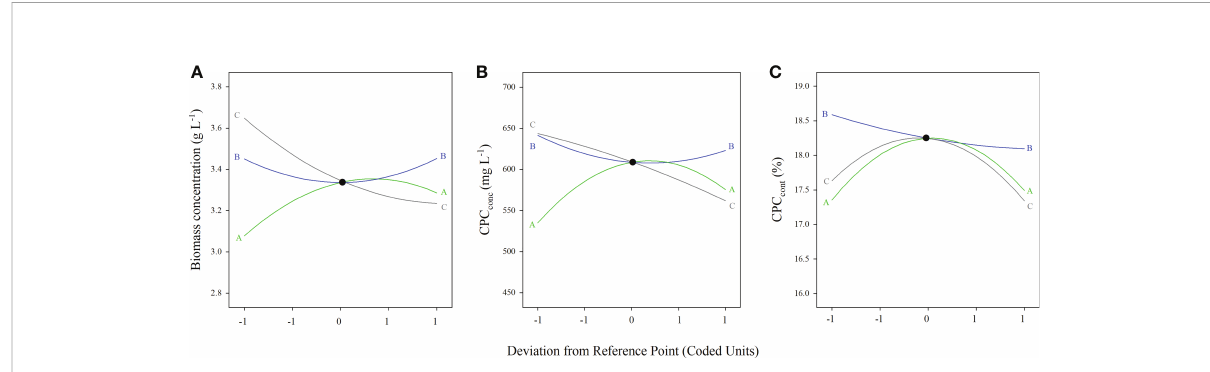
FIGURE 1 Perturbation plots of the dependent variables. (A) biomass concentration, (B) CPC conc , and (C) CPC cont . (A) NaCl concentration; (B) BS concentration; (C) BT